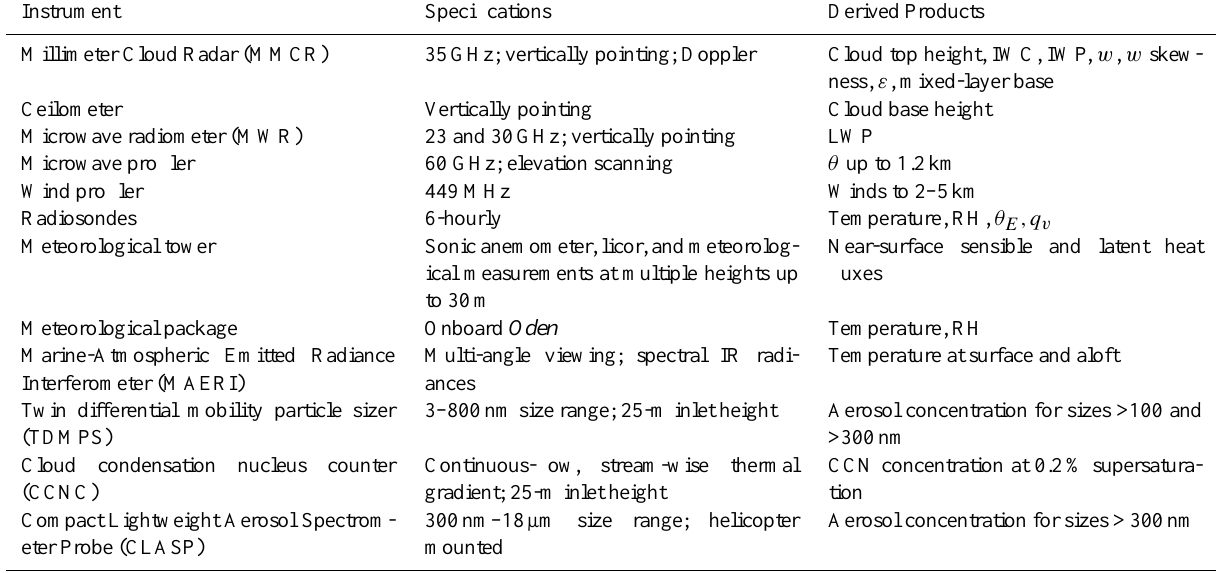
Table 1. Instruments, with pertinent specifications and derived